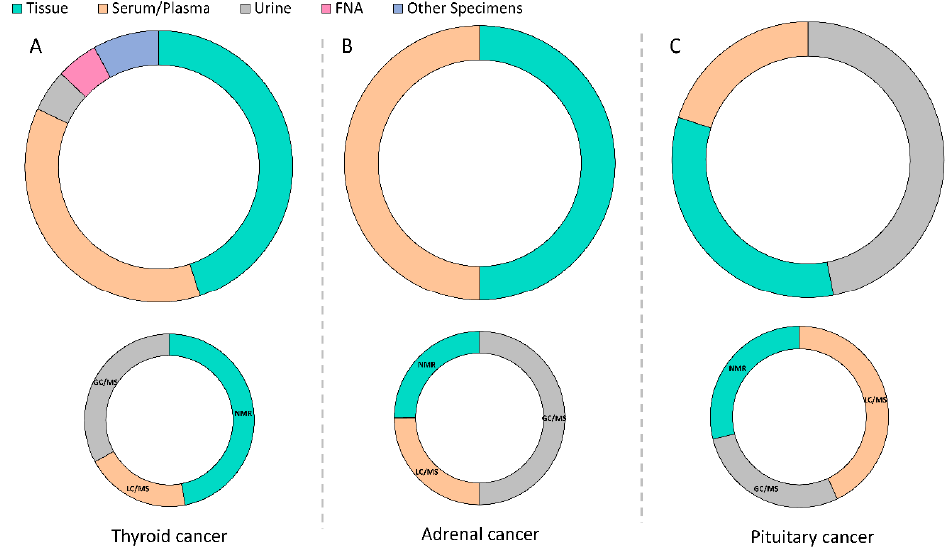
Figure 3. An overview of endocrine cancers metabolomics studies from 2010 to 2022. ( A – C ): the top row displays the percentage of each sample type used in the reviewed studies, and bottom row represent the percentage of analytical methods used for each endocrine cancer type. Keys: FNA, fine needle aspiration; NMR, nuclear magnetic resonance; GC/MS, gas chromatography-mass spectrom- etry; LC/MS, liquid chromatography-mass